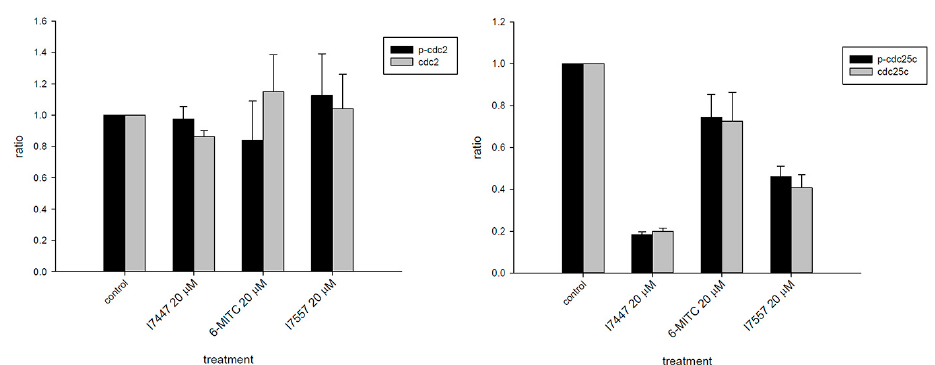
Figure 6. Expression of mitosis-related signaling molecules in SAS cells. Cells were treated with 20 µM of 6-MITC, I7447, and I7557 for 6 h, and then cell lysates were harvested. Equal amounts of proteins were subjected to western blot to detect mitosis-related protein expression. The representative immunoblots of mitosis-related proteins were indicated ( A , B ). The bottom part ( B ) shows levels of non-phosphorylated and phosphorylated Cdc2 and Cdc25c, relative to cells treated with vehicle alone ( B ).